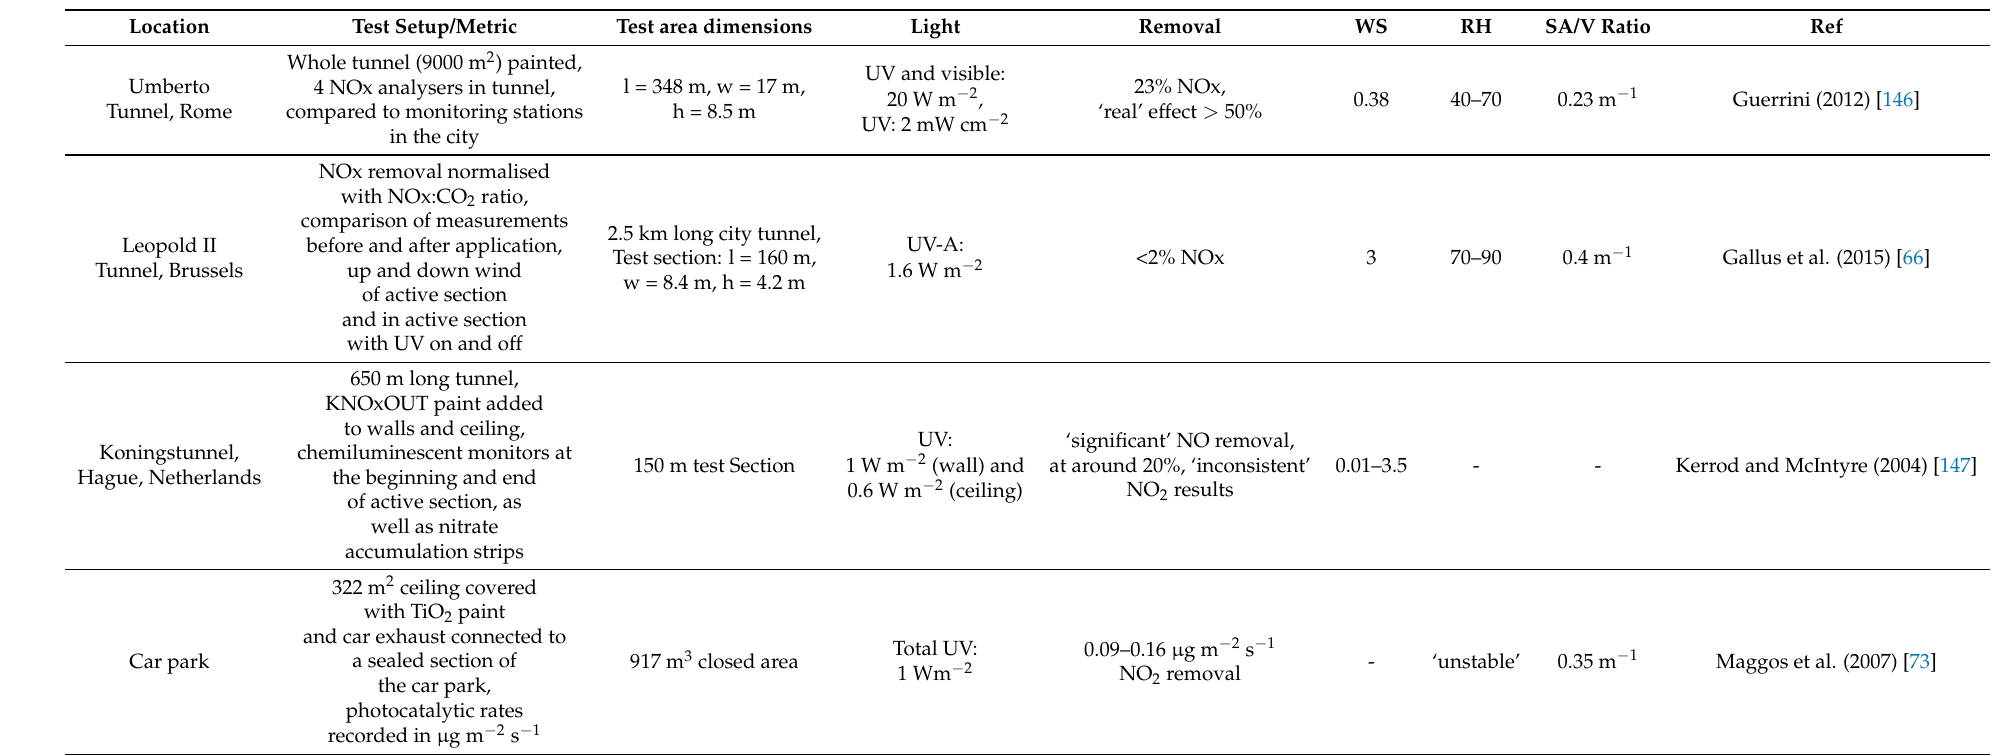
Table 6. Tunnels and enclosed